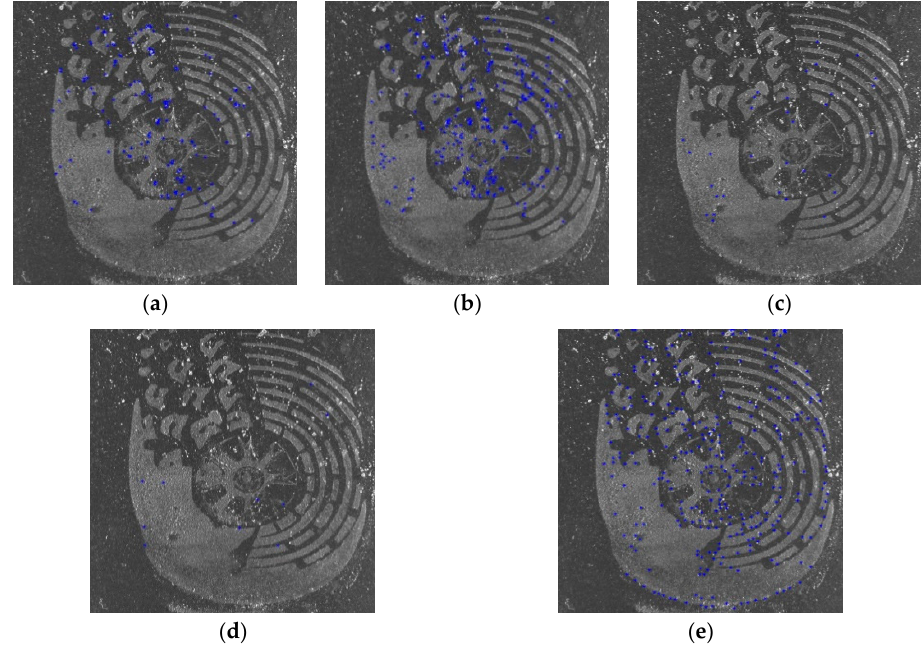
Figure 13. The results of our method and the compared methods on shoeprint made by different shoes. The unmatched points are labeled with blue ‘*’s. The more points are labeled, which should include red circled points in Figure 12a at least, the better the algorithm performs. ( a ) The results of Harris_HOG; ( b ) the results of Harris_NCC; ( c ) The results of Shitomasi_NCC; ( d ) the results of Shitomasi_HOG; ( e ) the results of our method.